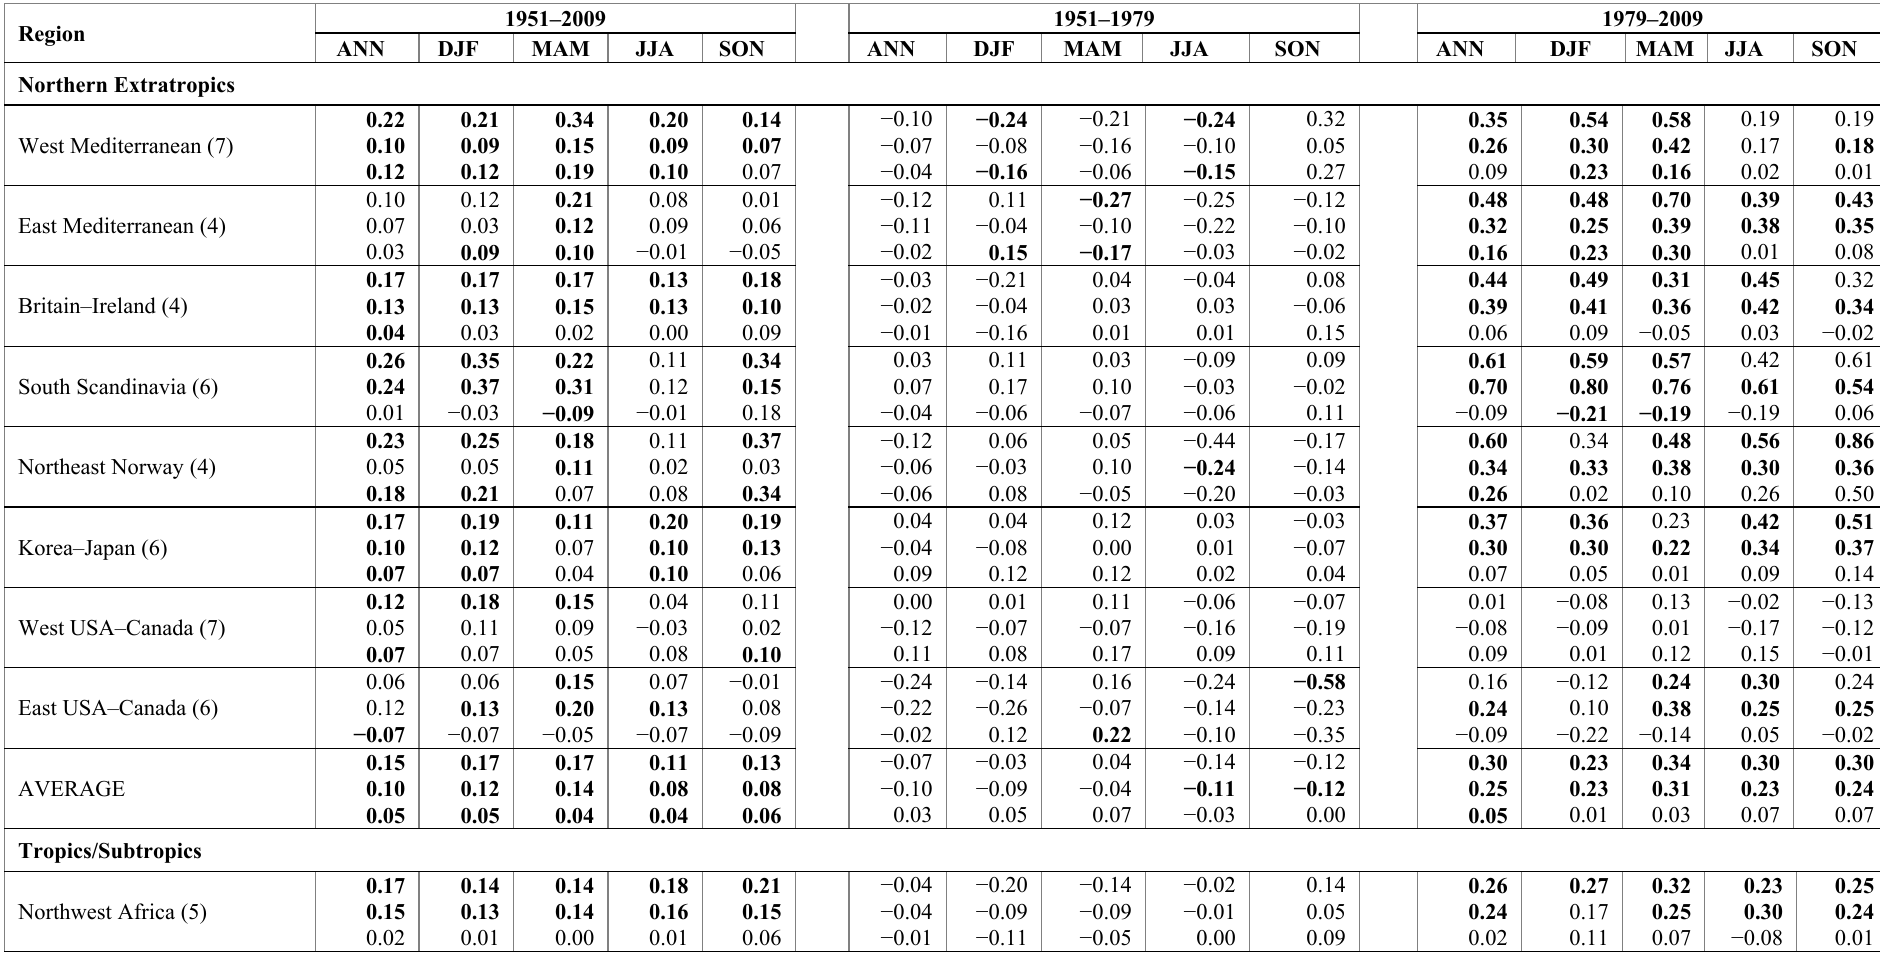
Table 1. Linear trends of temperature time series (°C/decade) for regional and wide-scale geographical domains over 1951–2009 (left side), 1951–1979 (middle) and 1979–2009 (right side). In each cell the upper, middle, and lower numbers correspond to CRUTEM3, HadSST2 and CRUTEM3–HadSST2 difference series, respectively. Trends significant at the 95% level are in bold. Numbers in parentheses next to the regional names indicate the number of 5° by 5° latitude/longitude grid boxes selected to calculate the regional time